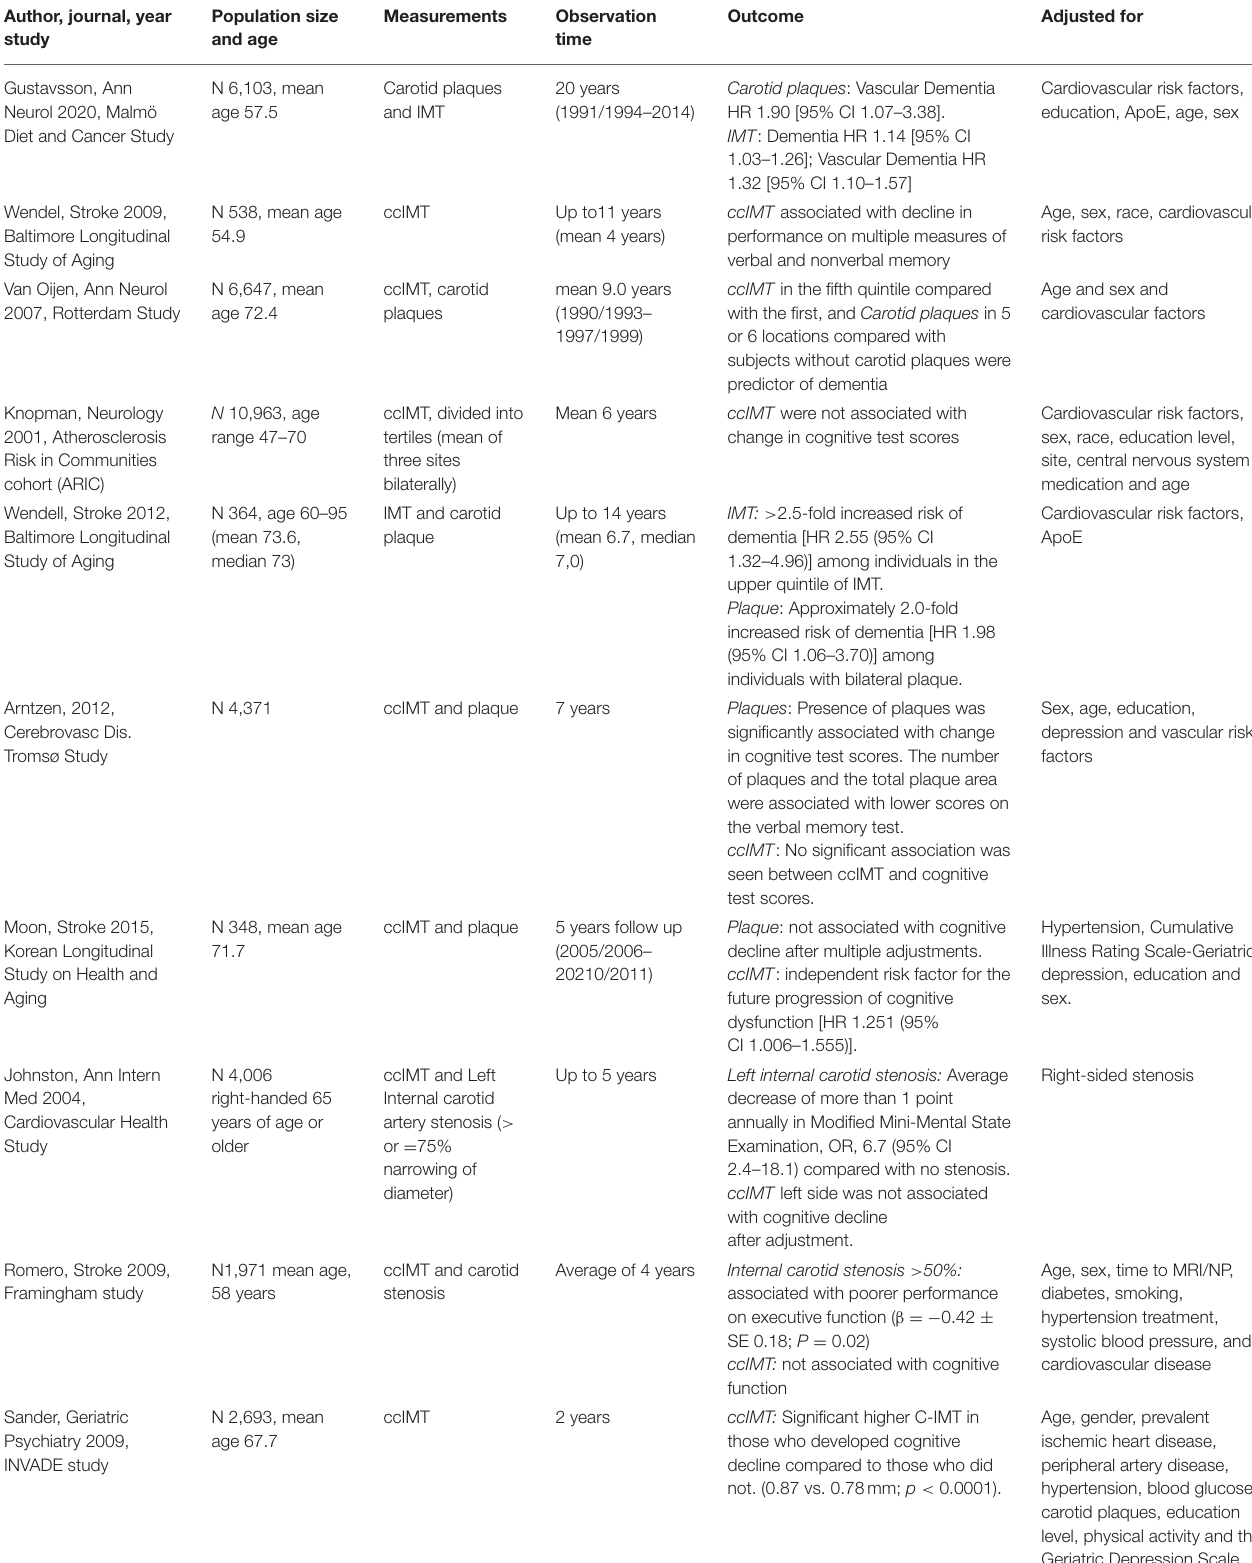
TABLE 1 | Excerpts from relevant populations-based